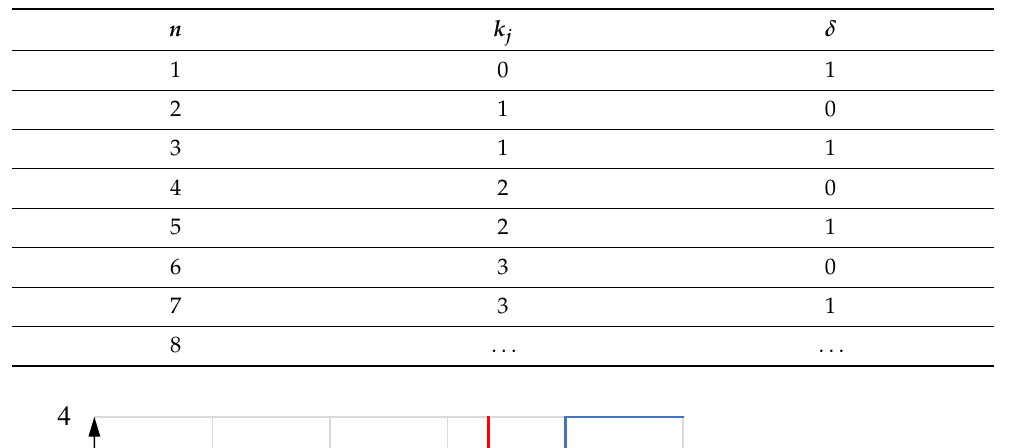
(cid:16) (cid:17) k j , δ .